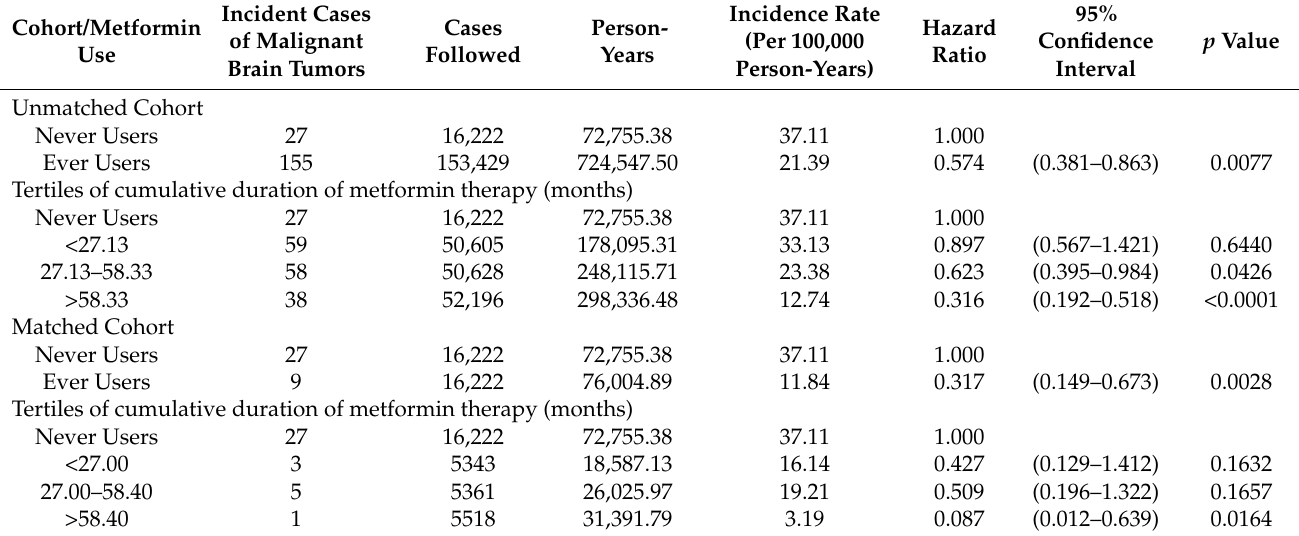
Table 2. Incidence rates of malignant brain tumors and hazard ratios by metformin exposure.